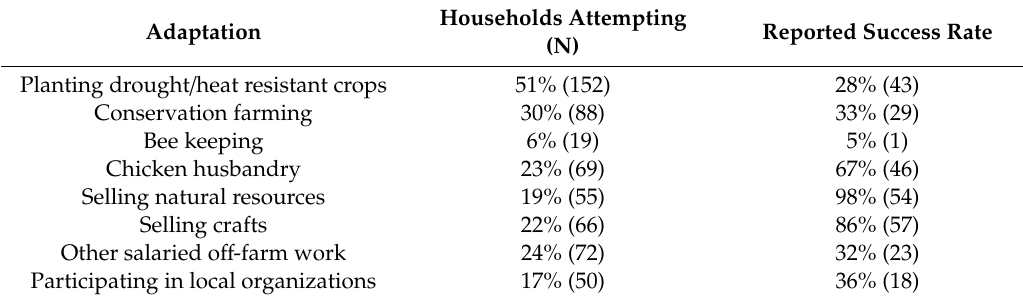
Table 2. Proportion of households (total) attempting each adaptation and proportion of those that attempted andreported success (measured as increase in income, food consumption, or agricultural output). Adaptation